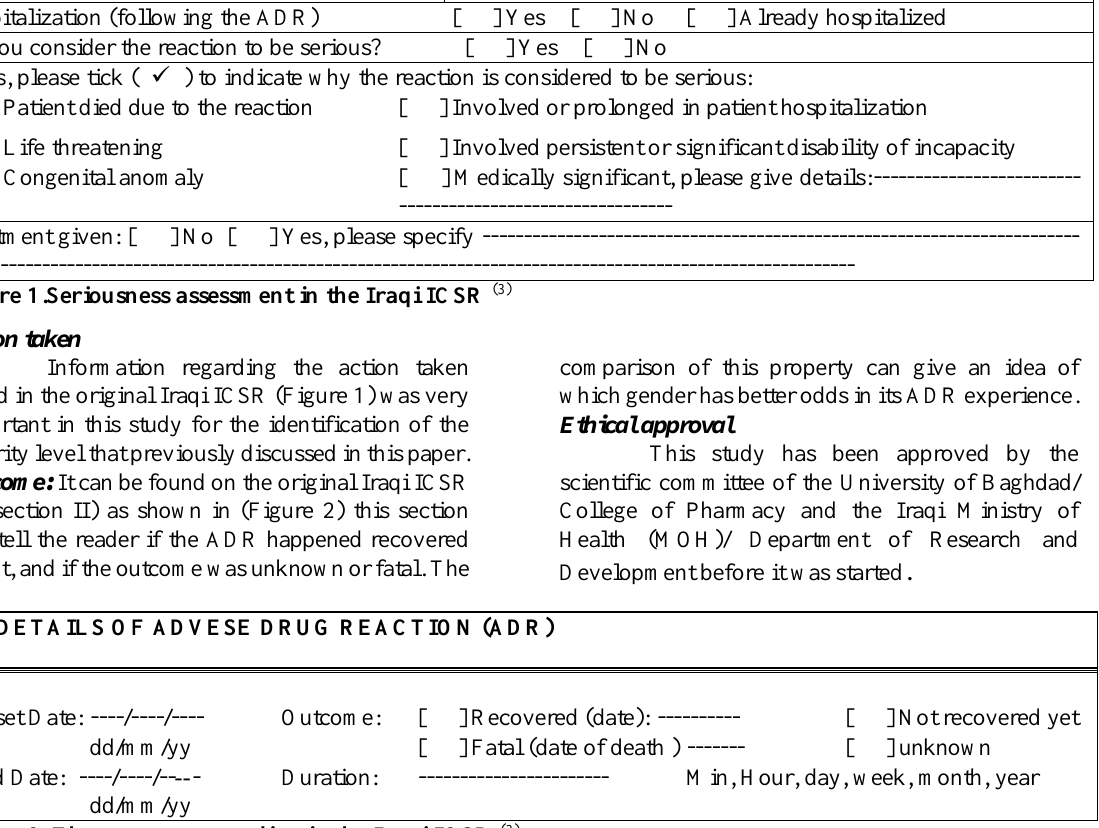
Figure 2. The outcome recording in the Iraqi ICSR